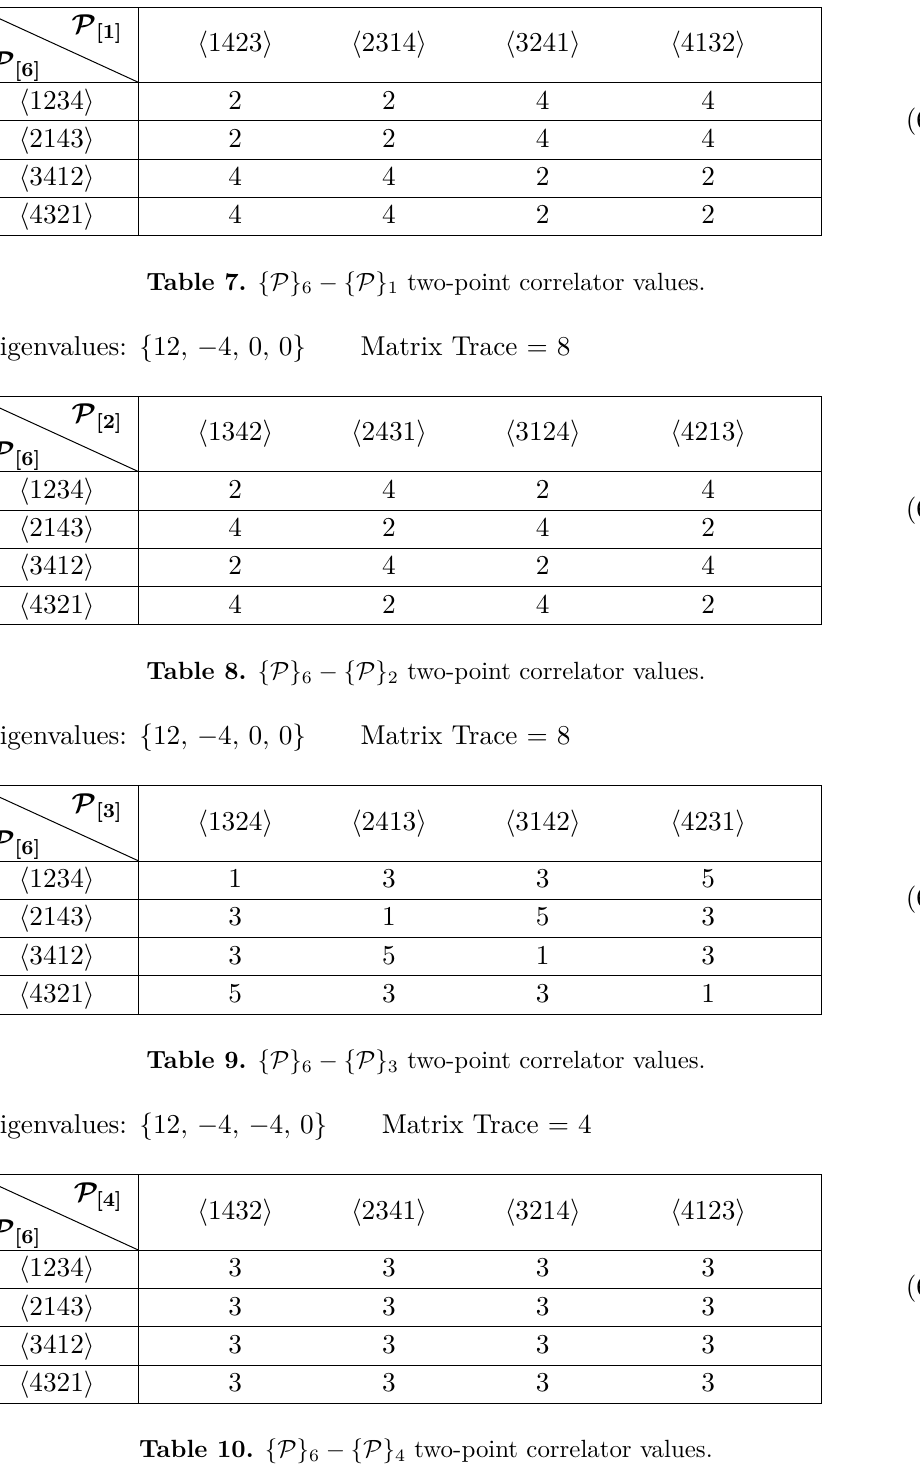
Table 10. {P} 6 − {P} 4 two-point correlator